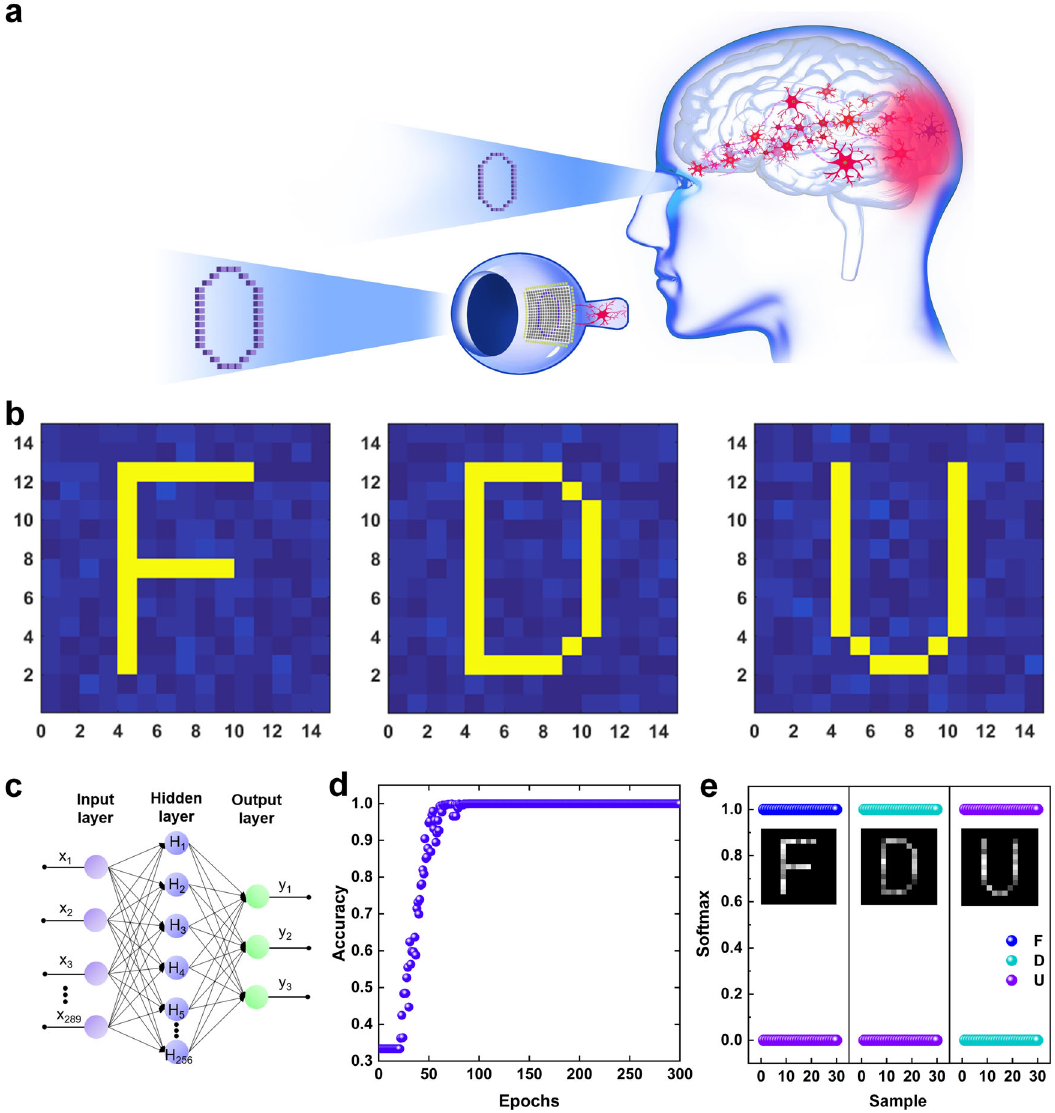
Fig. 5 The simulation of an arti fi cial neural network (ANN) based the fabricated β -Ga 2 O 3 phototransistor. a Schematic of simulating the human nerve visual system. b Illustration of corresponding UV detector arrays. c Illustration diagram of arti fi cial visual-neural network. d The recognition rate of UV detector arrays recognizing image. e The probability for three possibility results when the letters in image database are input into the trained Supplementary Table 1 provides a summary and comparison of key parameters for the reported UV photodetectors based on various materials. By contrast, the maximum R of β -Ga 2 O 3 phototransistor (1.32 × 10 6 A/W) fabricated in this work is 100 times more sensitive than the traditional material photodetectors (such as GaN (10 4 A/W), SiC (0.18 A/W), ZnO (12 A/W), and others) 54 – 59 . In addition, the R of β -Ga 2 O 3 phototransistor is also improved by more than 100 times than the reported the perovskite-based UV photodetectors (BiOBr (1.27 × 10 4 A/W),